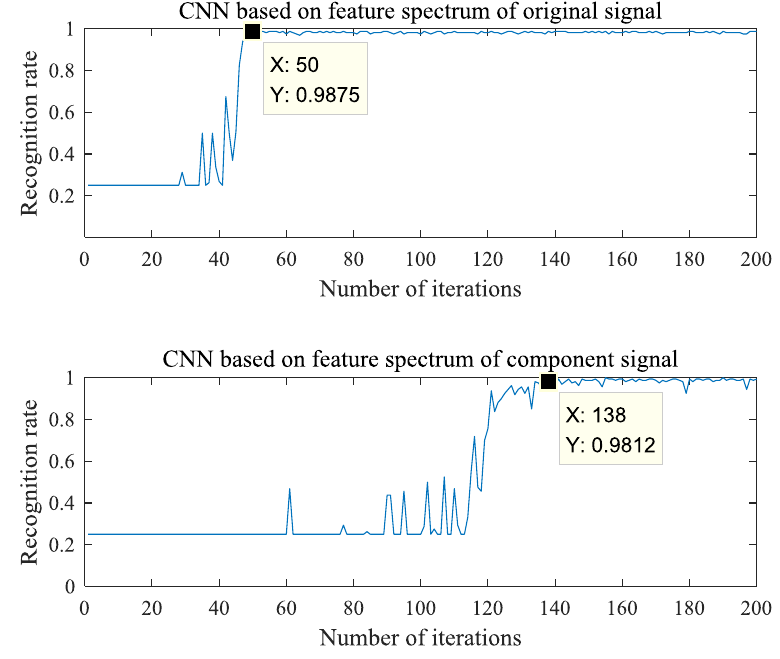
Figure 13. Recognition rate varies with the number of iterations.